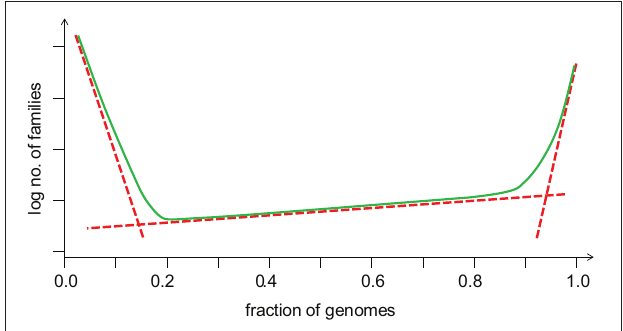
FIGURE 4 | The universal distribution of gene commonality in the microbial genomic universe: a generalized schematic. The three broken lines represent three exponential functions that fit the core (on the right), the shell (in the middle) and the cloud (on the left) of prokaryotic genes (O’Malley and Koonin, 2011).